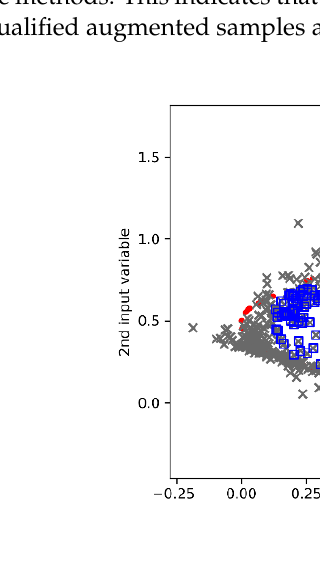
Figure 5. Scatter distributions for the numerical example: ( a ) original data and rough generated data, and ( b ) qualified virtual samples. Table 1. Performance comparison of SWGAN-SVR and other methods for the numerical example.